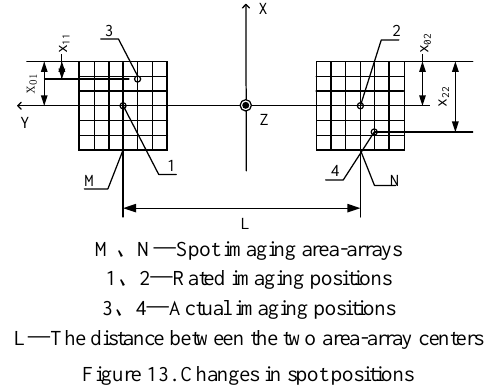
Figure 12. The camera rotates around the visual